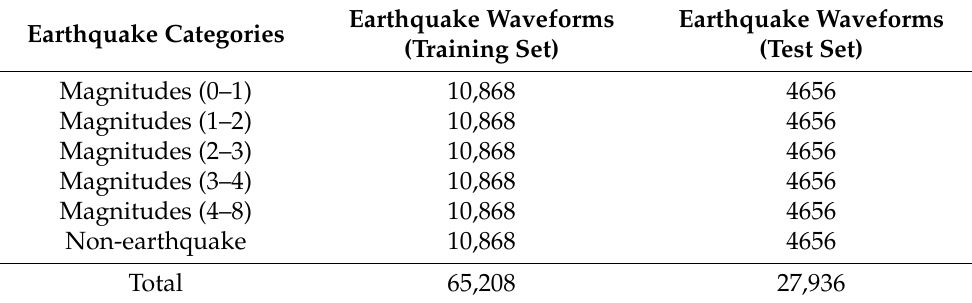
Table 1. Multi-class dataset orientation for earthquake waveform